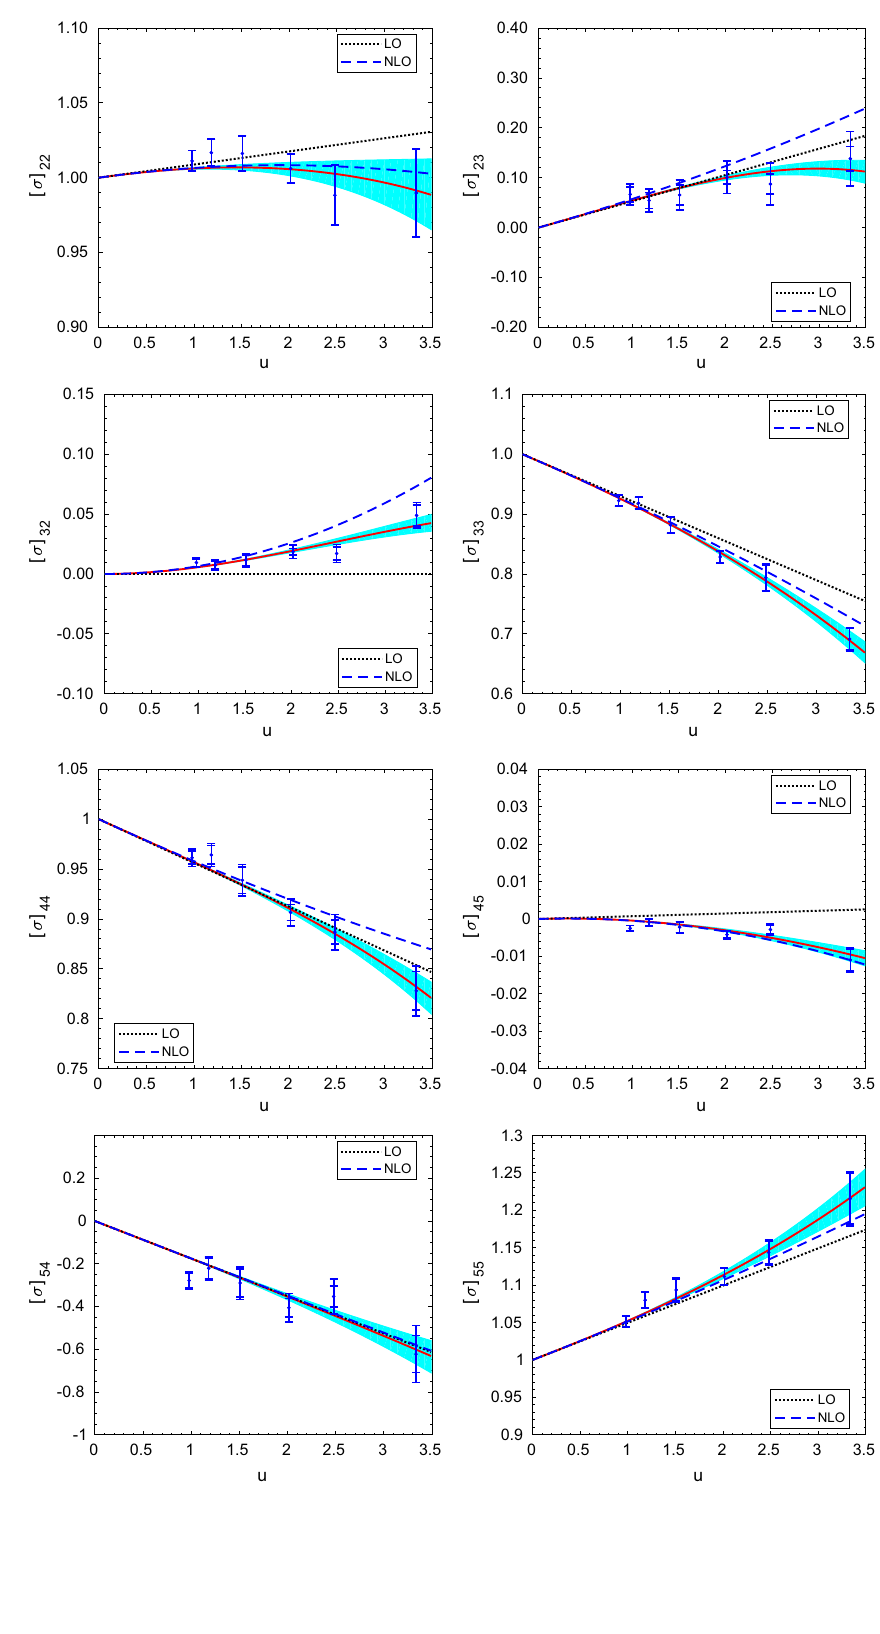
Fig. 6 Continuum matrix-SSFs , Q + } for operator bases { Q + 2 3 , Q + } (bottom). (top) and { Q + 4 5 The LO perturbative result is shown by the dotted black line, while the NLO one by the dashed blue line. The red line (with error band) is the non-perturbative result from the O ( u 3 ) fit as described in the text. The two error bars on each data point are the statistical and total uncer- tainties; the systematic error contributing to the latter has been